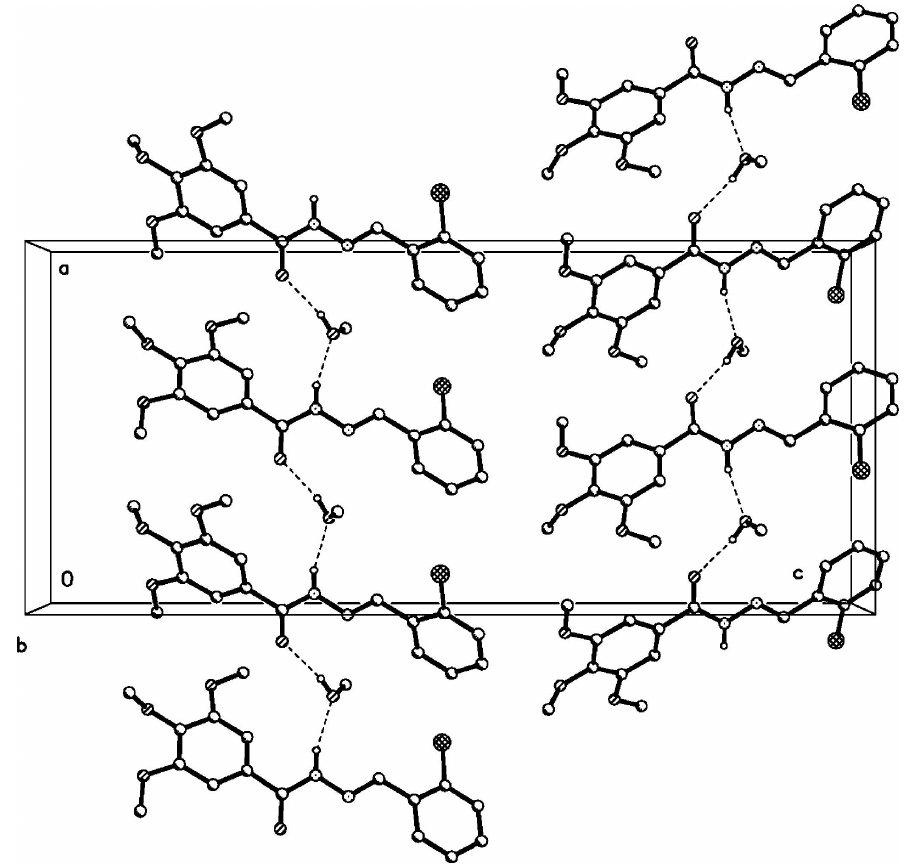
Figure 2 The packing of (I), viewed down the b axis. The dashed lines represent the hydrogen bonding interactions.